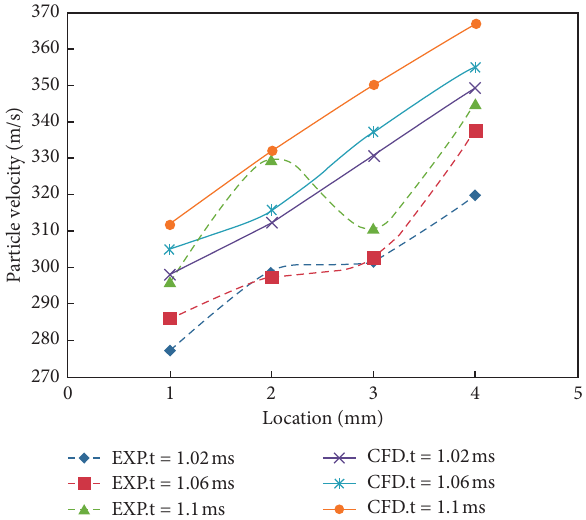
Figure 15: Particle velocity at the exit of sonic